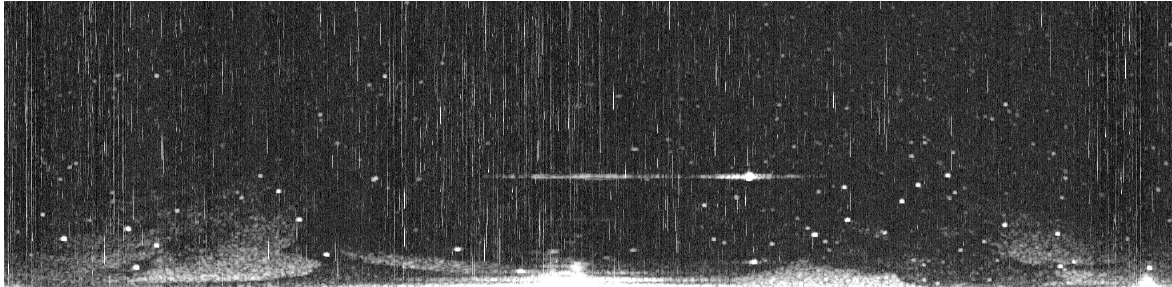
Figure 8. Converted X band marine radar